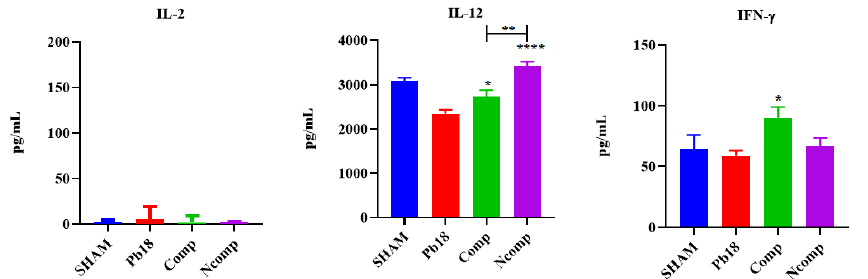
Figure 6. Th1 cytokine production 51 days post infection. No IL-2 was detected, and the IL-12 and IFN- γ were significantly increased, when compared to the Pb18 group. SHAM (non-infected and non-treated), Pb18 (infected and non-treated), Comp (infected and treated with the P10 complexed nanoparticles) and Ncomp (infected and treated with the P10 co-administered with empty nanoparticles). * = p < 0.05; ** = p < 0.01 and **** = p < 0.0001.